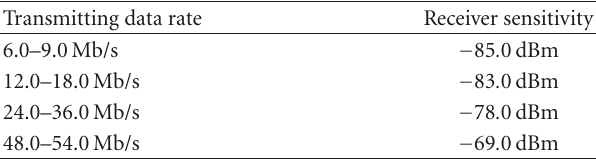
Table 3: Receiver sensitivity for transmitting data